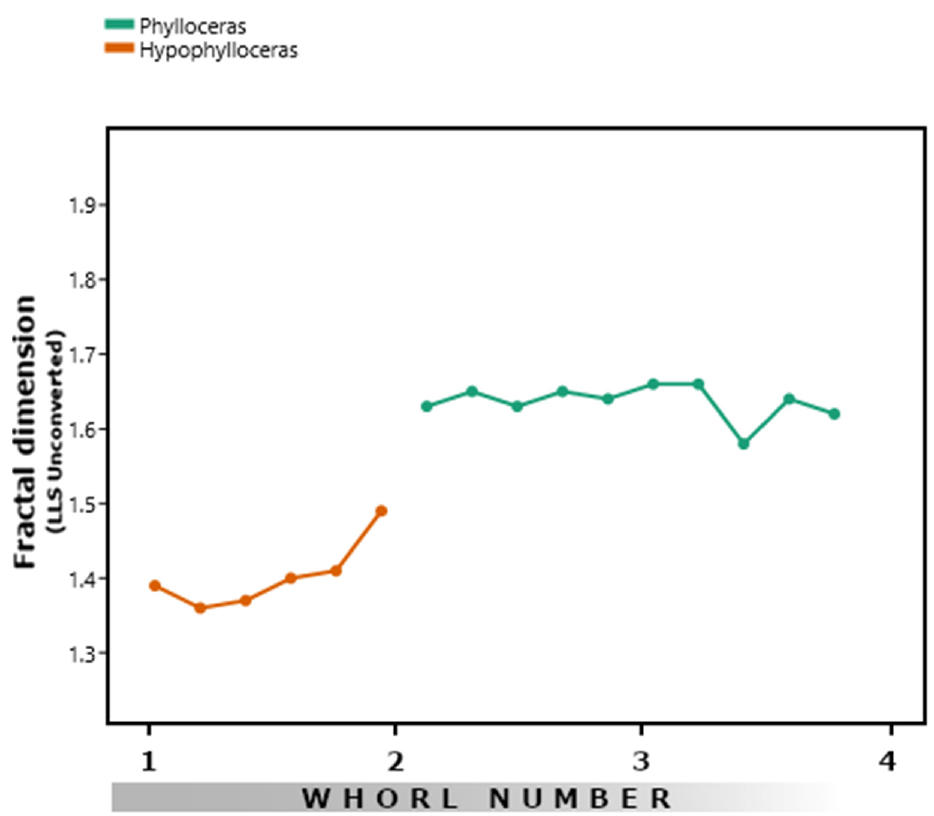
Figure 7. Ontogenetic sequences of phylloceratid suture complexity. The fractal dimensions can be found in File S1 in the Supplementary Materials.